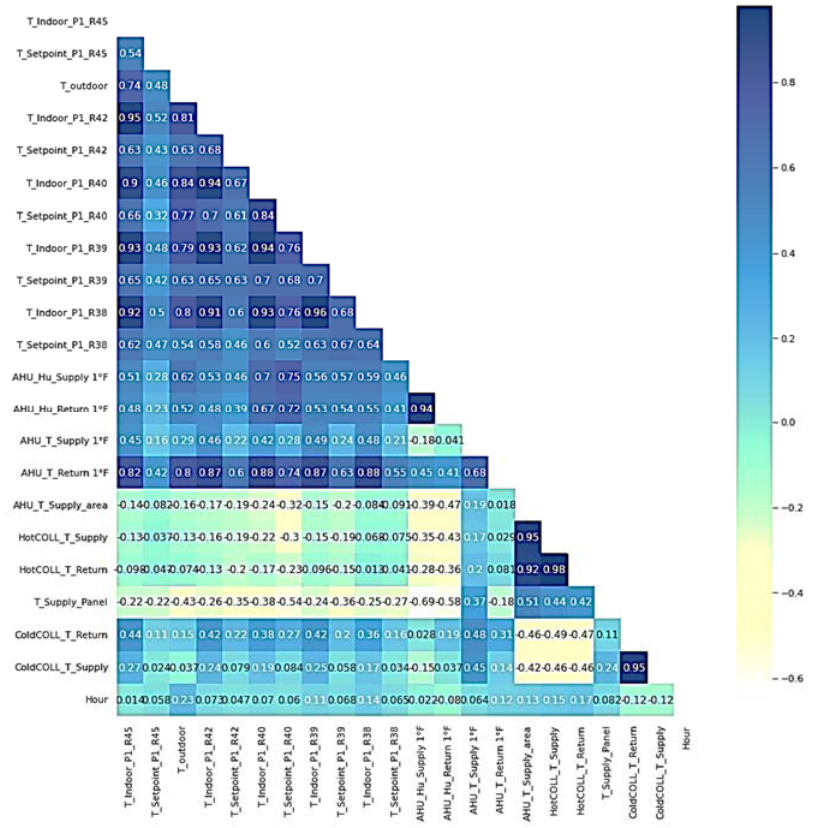
Figure 3. Correlation matrix between available features.